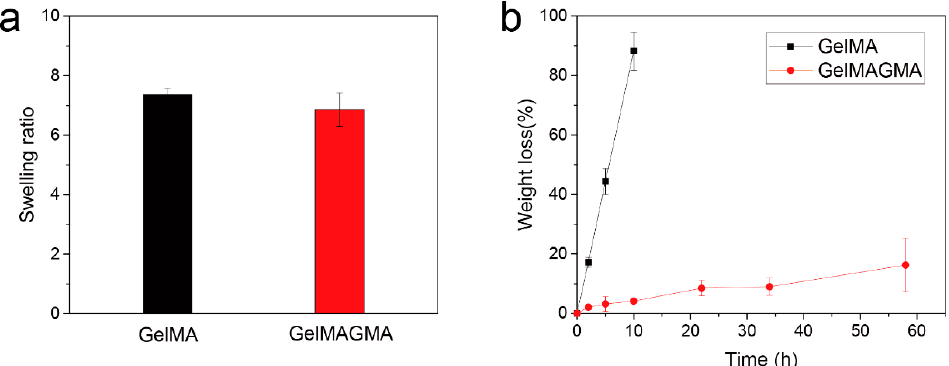
Figure 3. Equilibrium swelling ratio of GelMA and GelMAGMA hydrogels ( a ), the data represent means ± SD, N = 3. Enzymatic degradation of GelMA and GelMAGMA hydrogels in the presence of 10 unit mL − 1 of collagenase type I at 37 °C with shaking ( b ), the data represent means ± SD, N = 5.